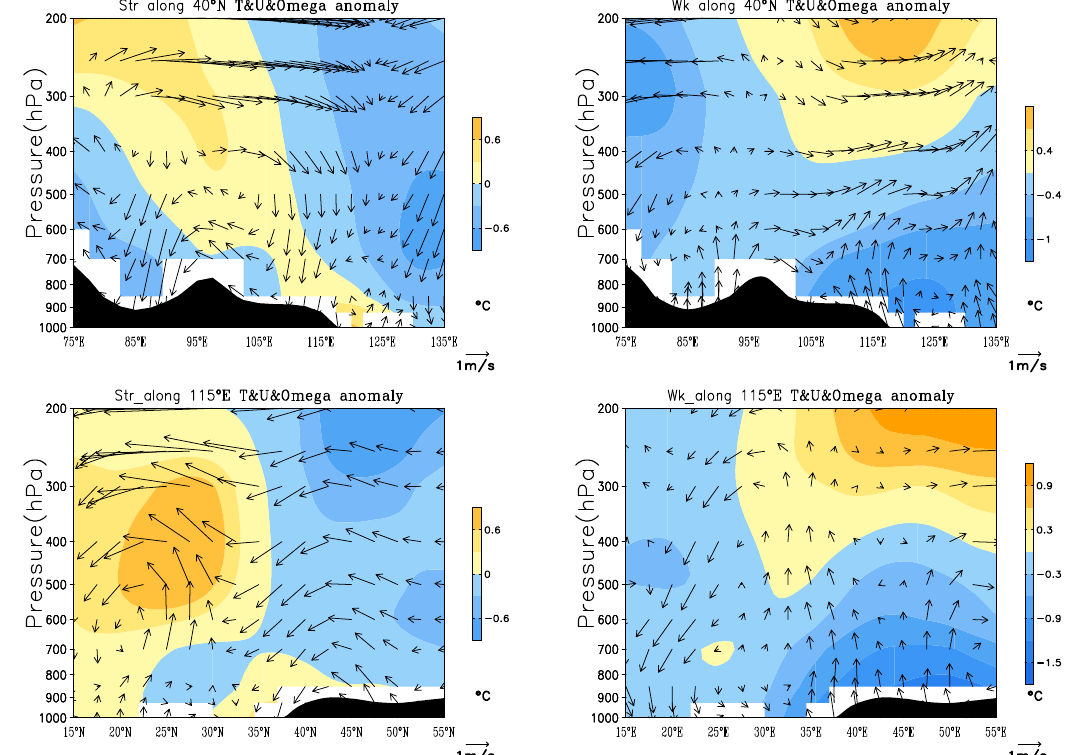
Figure 6. Circulation and temperature fields in the east-west section ( top ) and north-south section ( bottom ) of Beijing-Tianjin-Hebei region in strong ( left ) and weak ( right ) cold source years on the Qinghai-Tibet plateau.